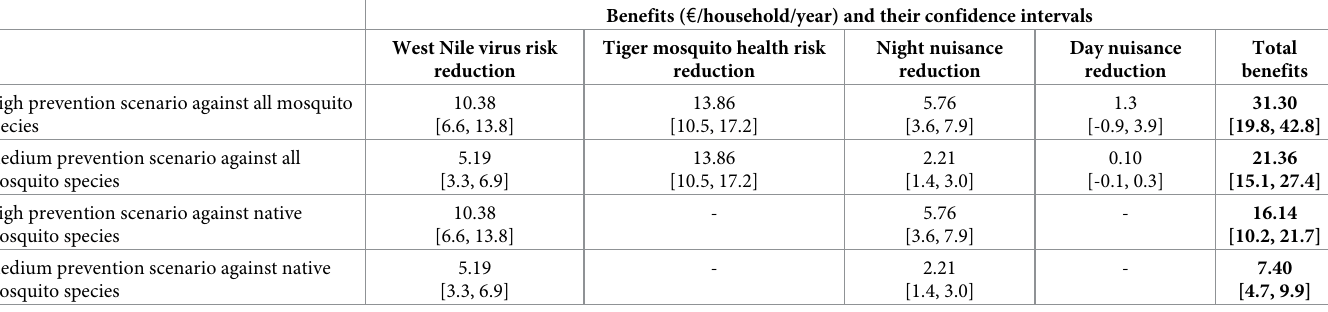
Table 3. Households’ benefits as estimated for various prevention scenarios (results from the survey conducted in Athens [21]). Benefits ( € /household/year) and their confidence